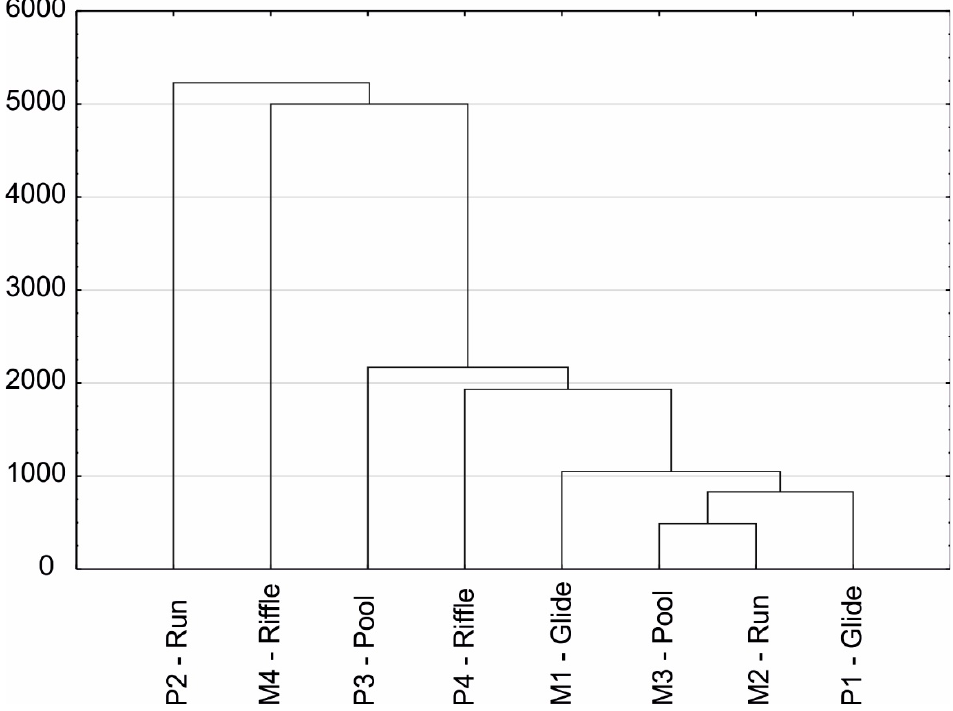
Figure 6. Hierarchical cluster analysis based on the density of macroinvertebrate groups in the Por ę bianka and Mszanka rivers.